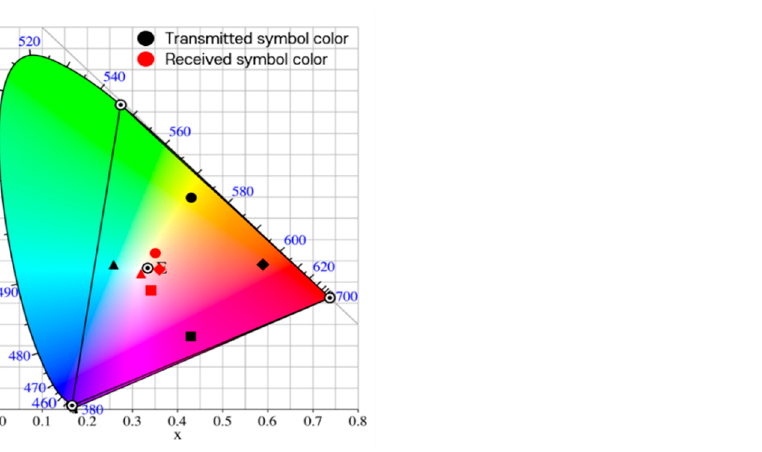
Figure 7. Distortion of the symbol transmission/reception process as observed in the real world.